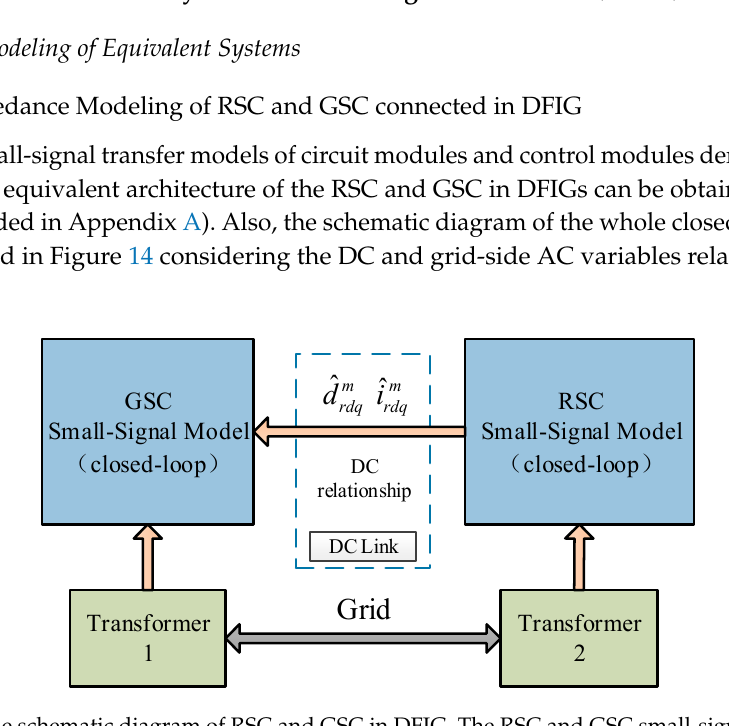
Figure 13. The small-signal transfer diagram of PLL in GSC control, which shows the transfer relationship of variables from the circuit module to the control module.